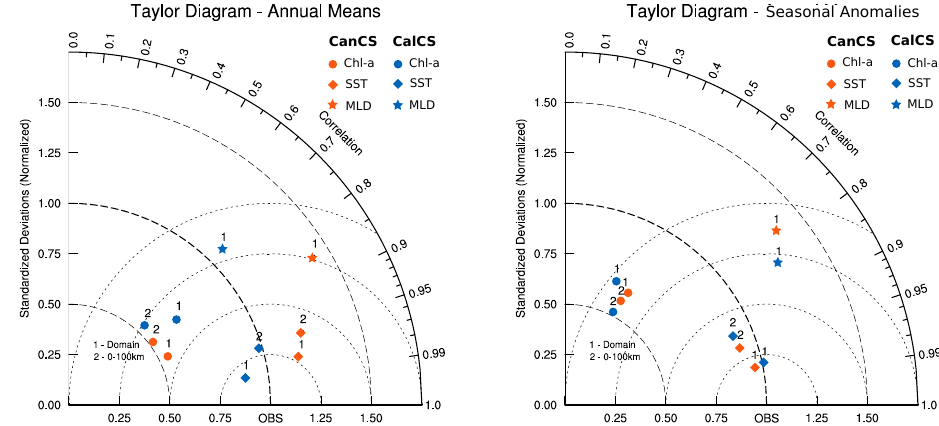
Fig. 3. Taylor (2001) diagrams of modeled annual-mean (left) and seasonal anomalies (right) of surface chlorophyll (circles), sea surface temperature (diamonds) and mixed layer depth (stars) in the California CS (blue) and the Canary CS (orange). The reference point of the Taylor diagram corresponds to SeaWiFS observations for chlorophyll, AVHRR data for temperature and the monthly climatology of de Boyer Mont´egut et al. (2004) for the mixed layer depth. The statistics were computed separately for the entire domain (data points labeled “1”) and the 100km wide nearshore region (data points labeled “2”).